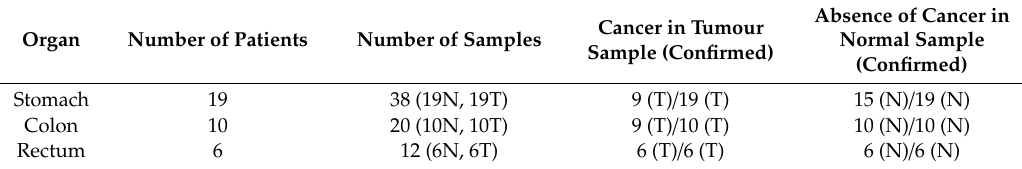
Table 1. Samples used for data